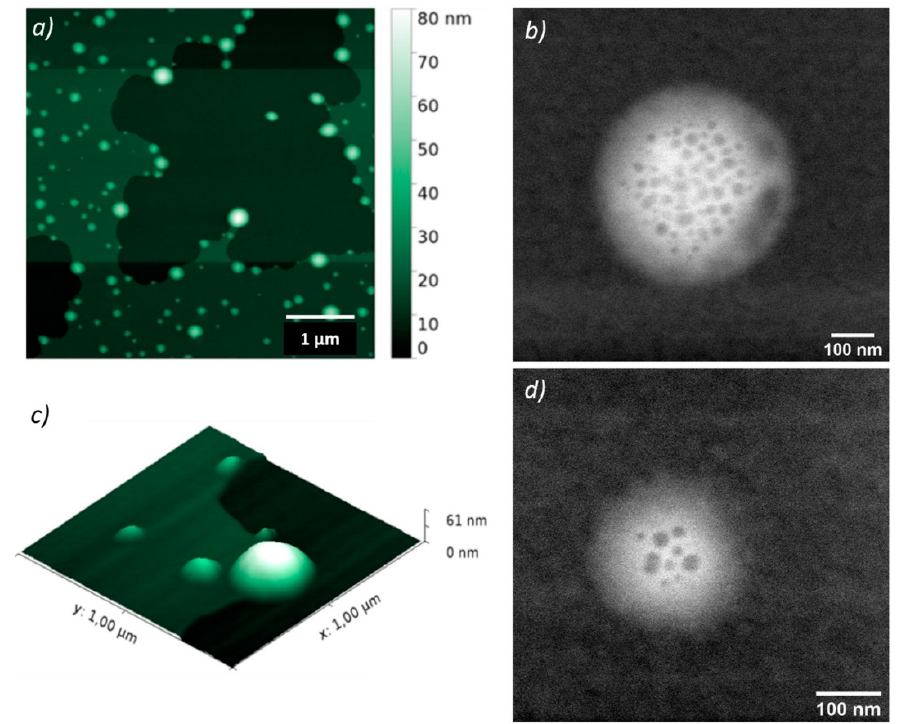
× 5 µ m2)ofDOX_MagLipodriedonasiliconsubstrate. ( b Figure 3. ( a ) AFM scans (5 × 5 µm 2 ) of DOX_MagLipo dried on a silicon substrate. ( b ) Three- Figure3. ( a )AFMscans(5